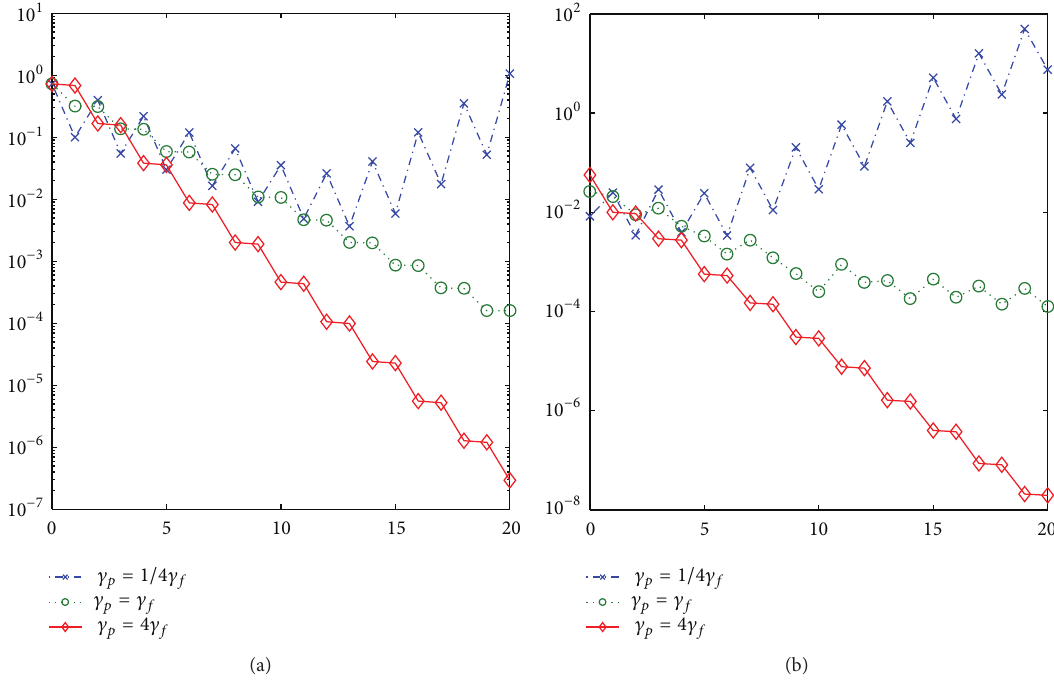
Figure 3: Convergence for the pressure of the free flow (a) and 𝜂 𝑓 (b) versus the iteration counter 𝑚 for the parallel DDM with BJS interface